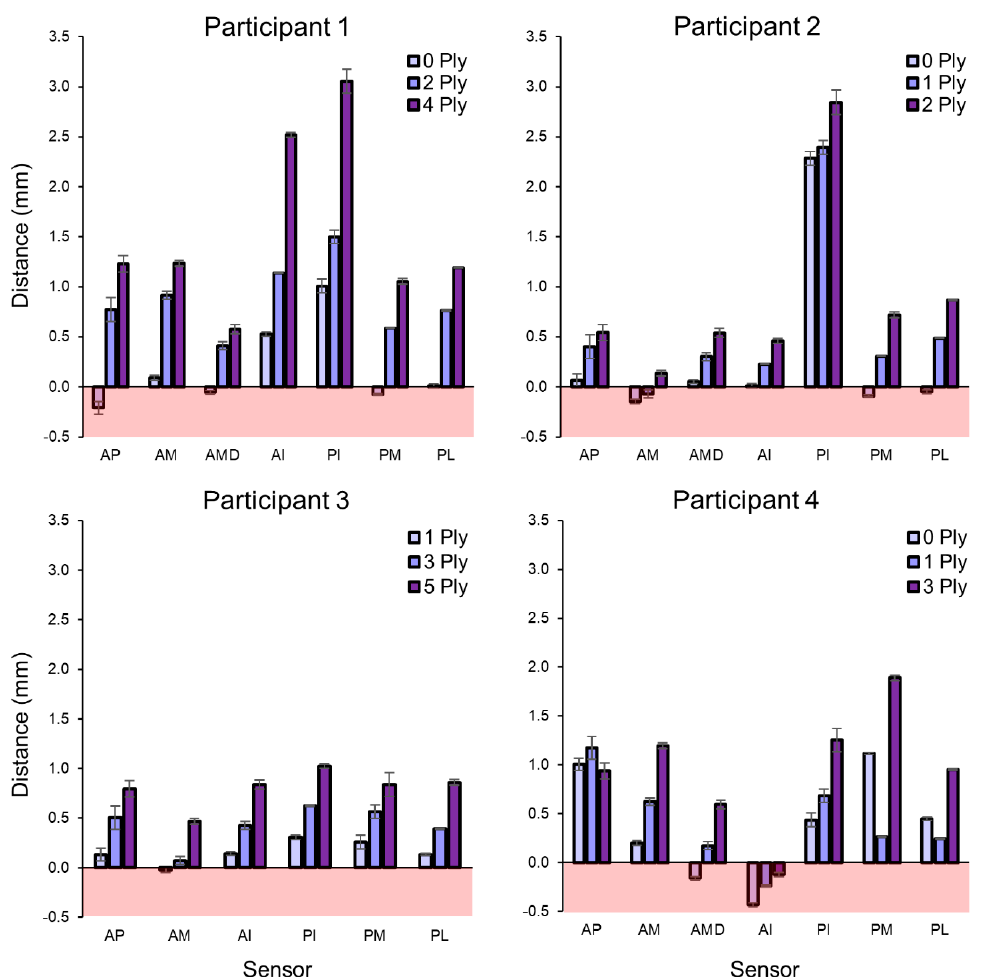
Figure 6. Average walking stance phase distances between the limb and socket by sock combination. As sock thickness increased, the limb typically moved further away from the socket wall. Distance measurements less than 0.0 mm indicate that the liner was under compression.